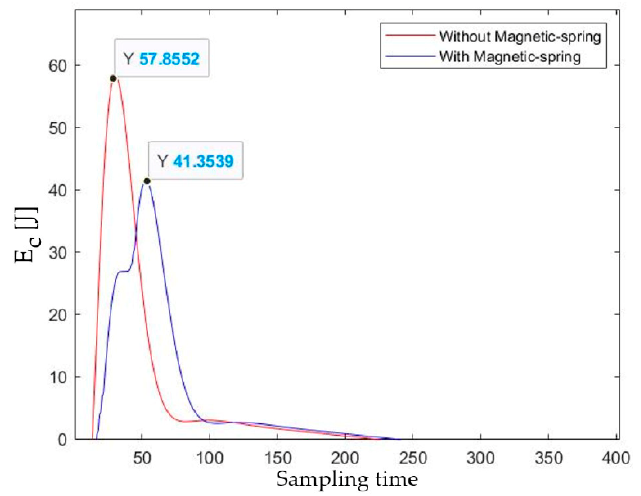
Figure 7. Simulation of the 3 states that allow generating the circular trajectory by implementing the PD-DGD-type control algorithm with gravity compensation: ( a ) startup, ( b ) trajectory, ( c ) return to startup.